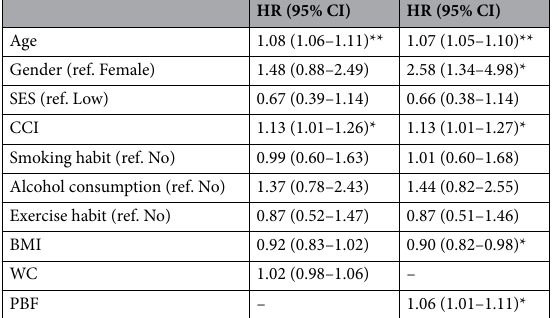
HR (95% CI) HR (95% CI) Age 1.08 (1.06–1.11)** 1.07 (1.05–1.10)** Gender (ref.